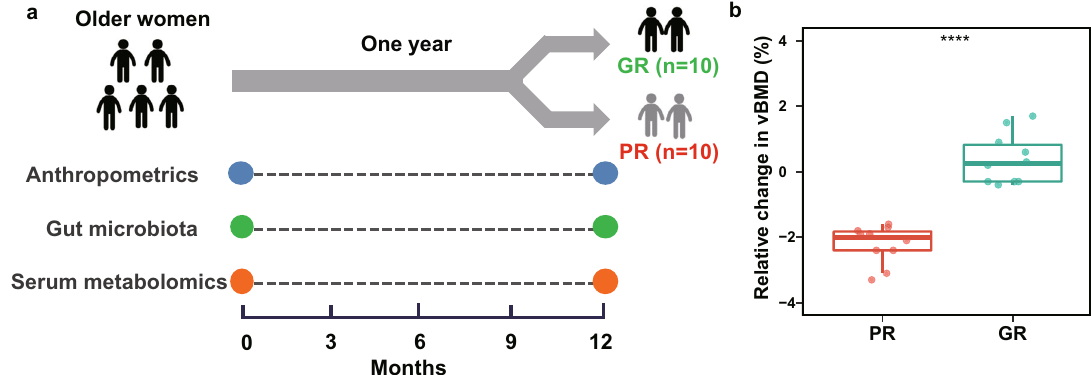
Fig. 1 The scheme diagram of experimental design for elderly women with differential responses to the supplementation with L. reuteri ATCC PTA 6475. a Women with a good response (GR group, n = 10) and with a poor response (PR group, n = 10) were recruited. Serum samples and fecal samples were collected from the older women with bone loss at baseline and 12 months. The complete metabolomic pro fi ling for these women were performed. However, for metagenomic pro fi ling, one woman in the GR and PR group lost one fecal sample, respectively. Therefore, nine women had time points-paired fecal samples in each group. b The boxplot shows the relative change of tibia total volumetric BMD in the GR and PR groups after one-year treatment. ‘ **** ’ denotes P < 0.001. The upper quartile, median and lower quartile are shown in the box